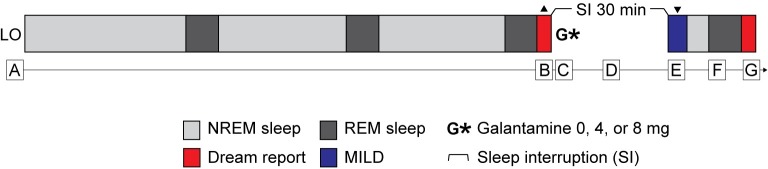
Schematic diagram of experimental procedure.(Note: figure not to scale, timing approximate). A. LO: Lights Out. Sleep for approximately 3 REM cycles. B. DREC: Recall and memorize dream upon awakening to use with MILD procedure at E. C. Ingest galantamine capsules. (All participants received all three doses (0, 4, and 8 mg) in one of 6 counterbalanced orders.) D. Sleep interruption (out of bed for 30 min). Engage in quiet activity with focus on lucid dreaming. (“Wake back to bed") E. Return to sleep practicing MILD using the dream recalled at B. F. Experimental Nap(s). G. REPORT: On awakening, dream recall, content scales, and full reports for lucid dreams.